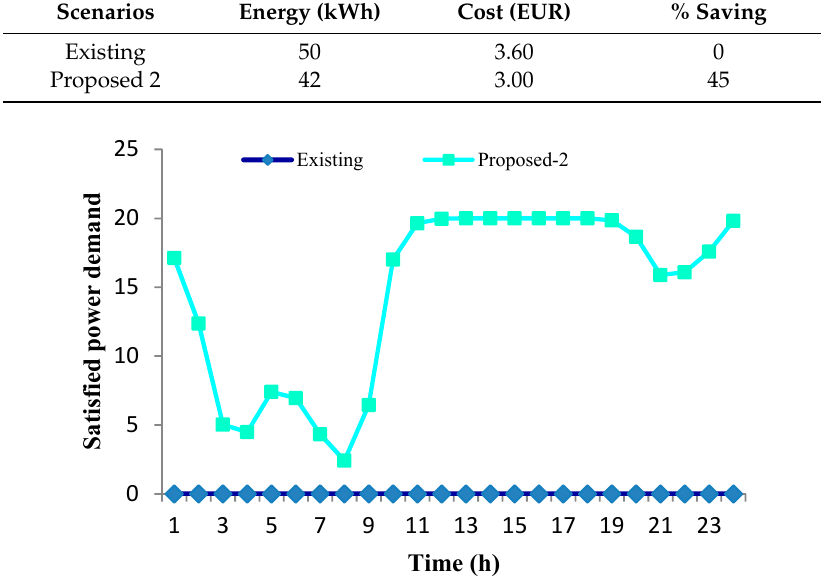
Figure 13. Comparison between proposed-2 and existing scenario of energy and electricity cost management over 24 h time horizon. Table 4. Comparison of the proposed and existing energy, and cost management for case-III.